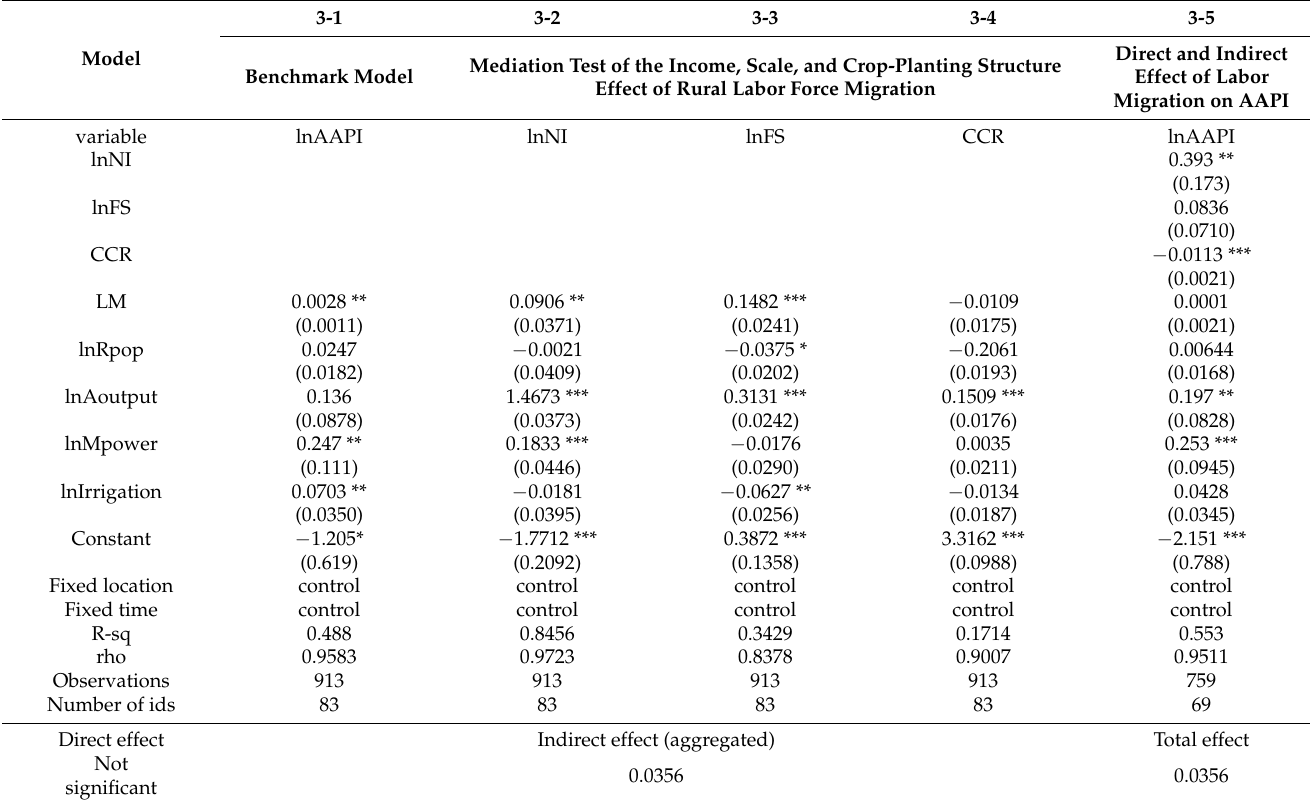
Table 5. Heterogeneity analysis: results of mediating effect model analysis in Hunan